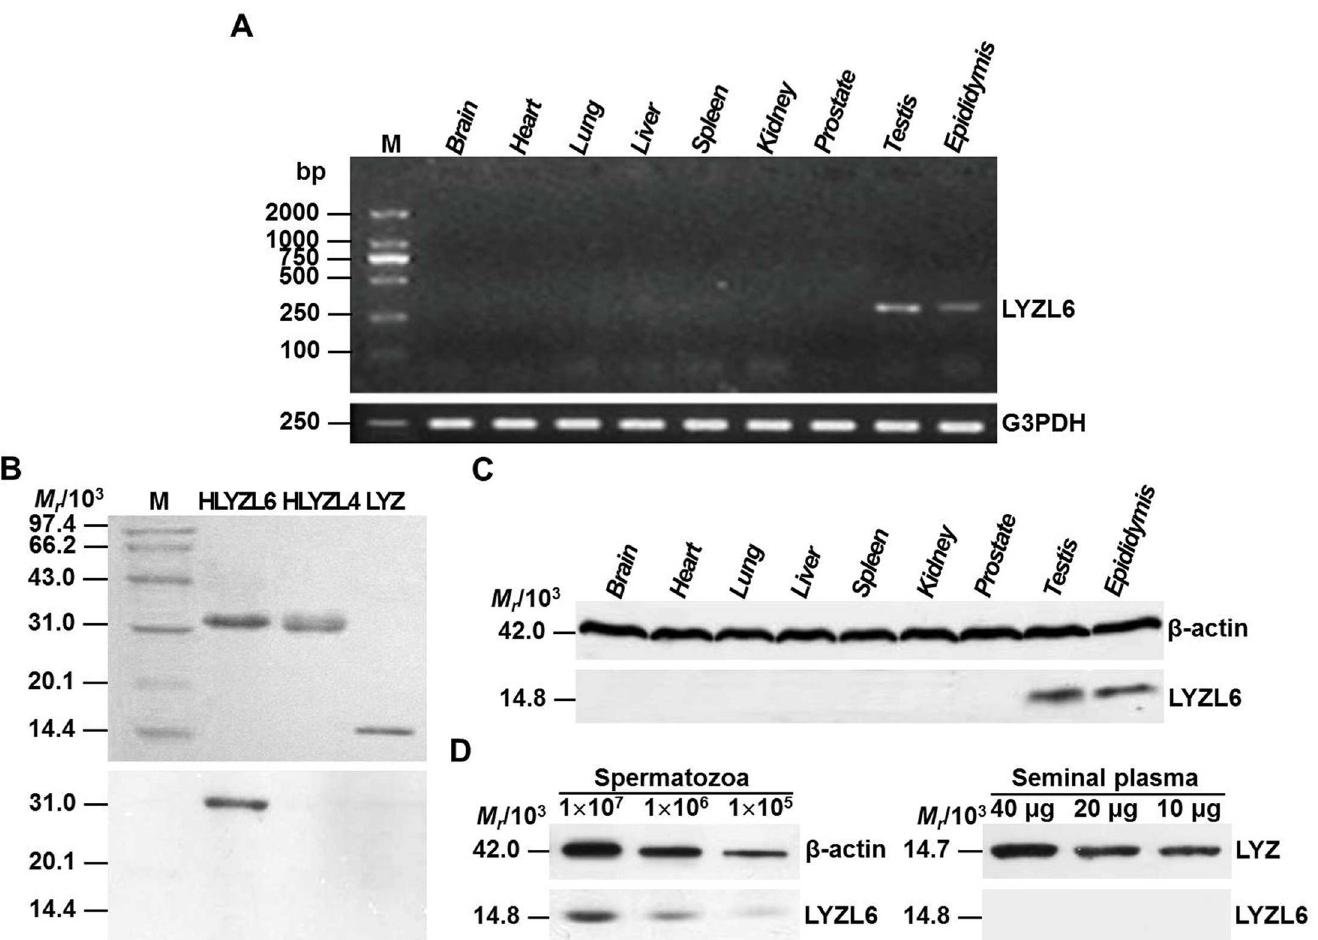
Fig 1. Tissue expressionpatterns of LYZL6. A) RT–PCR analysis. Lane M: DL2000DNA marker. The expectedsizes of PCR products were 296 bp for LYZL6 and 247 bp for G3PDH. Totally 14 tissues were examined.Nine of them were shown and the rest includedthe pancreas,small intestine, colon, thymus and skeletal muscle. B) Anti-LYZL6 serum specificity analysis. Top panel: SDS-PAGE; Bottom panel: western blotting. LaneM: molecularweight (MW) marker; The expectedMW was ~14.7 kDa for LYZ and ~32.0 kDa for His-taggedLYZL6 (HLYZL6) and His-tagged LYZL4 (HLYZL4), which the extra MW resulted from Trx-tag, S-tag and restriction enzyme site of the pET32a vector. The amount of His-taggedLYZL6 and His-taggedLYZL4 loaded was 0.5 μ g and that of LYZ was 0.1 μ g. C) Western blot analysisof humantissue extracts. A band corresponding to full-lengthLYZL6 was evidentin the testis and epididymis. No expressionwas detected in the other humantissues. D) Western blot analysisof LYZL6 in humansemen. LYZL6 was identified in protein lysates representingdifferent numbers of ejaculated spermatozoa(left), but not in seminal plasma (right). β -actin and LYZ were used as internal controls respectively.